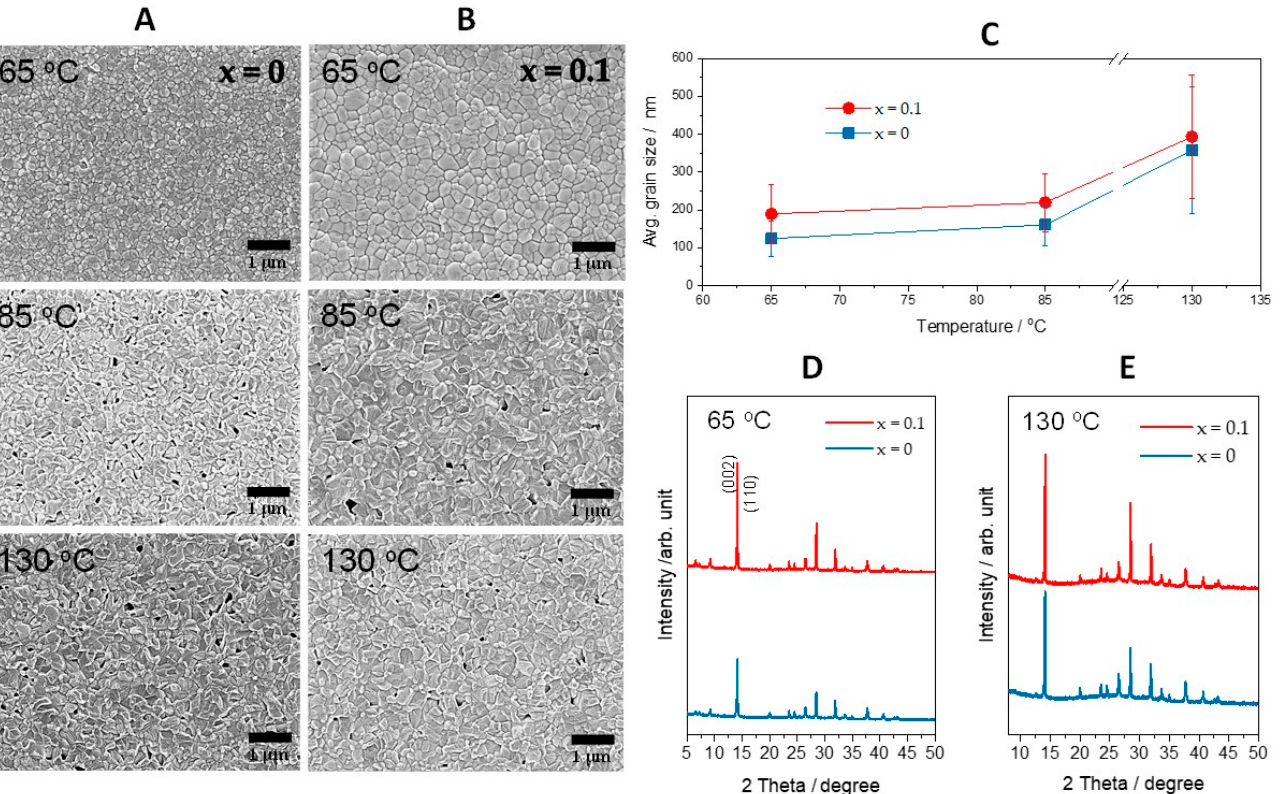
Figure 1. Corresponding In-situ SEM images of MAPbI 3 − x Cl x films imaged at various growth temperatures, ( A ) x = 0 and ( B ) x = 0.10, respectively. ( C ) Approximate average grain size during annealing process from in-situ SEM images. X-ray diffraction results of MAPbI 3 − x Cl x (x = 0, 0.10) from ( D ) soft baking at 65 °C for 1 min and ( E ) hard baking at 130 °C for 5 min.